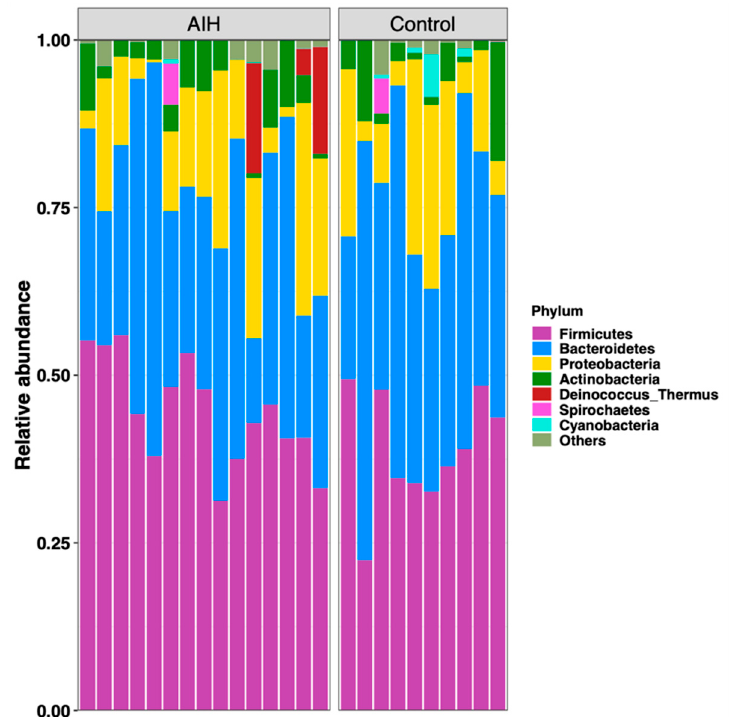
Figure 2. Phylum level analysis of gut microbiota among the studied groups.